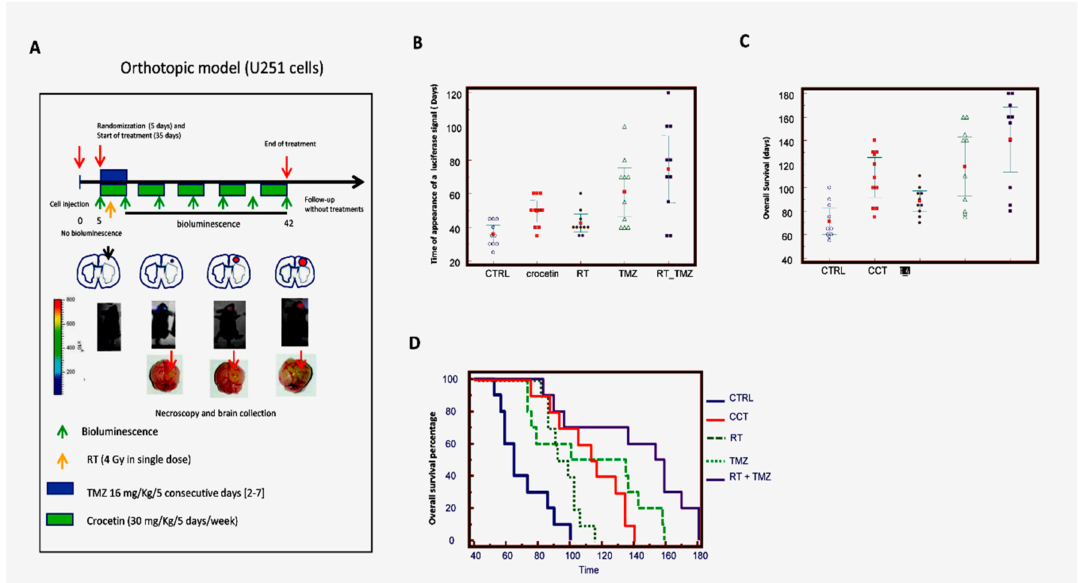
Figure 6. Crocetin increased disease-free and overall survival in orthotopic intra-brain tumors as determined by using a di ff erentiated Luc-U251MG cell model. Luciferase-tagged U251 cells (Luc-U251) were orthotopically injected into the brains of CD1 mice, as described. After 5 days (when no tumors were organized into the brain) the animals were randomized and treated with CCT (100 mg / kg / day per os), temozolomide (16 mg / kg for 5 consecutive days), RT (single dose of 4 Gy administered at day 5), and a combination of RT + TMZ (standard of care). ( A ) Schema of treatments and performed analyses. ( B ) Disease-free survival graph representation. ( C ) Overall survival data: graphical representation. ( D ) Kaplan–Meier graphical analyses. Parameters pertinent to our analyses were recorded, including: (i) tumor growth delay (the time at which luciferase activity was intracranially detectable), which indicated the recurrence time equivalent to the human parameter DFS; (ii) tumor progression through the analysis of bioluminescence imaging (BLI) photon counts and tumor volumes (calculated by magnetic resonance imaging, MRI); and (iii)